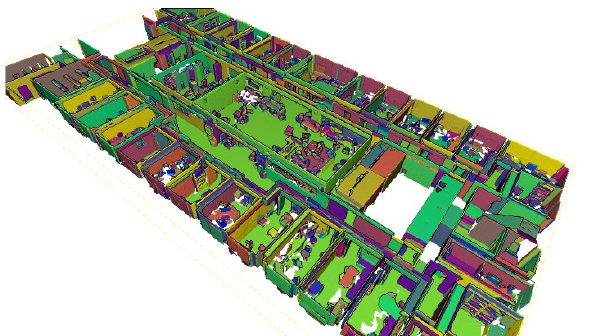
Figure 6 Segmentation results over